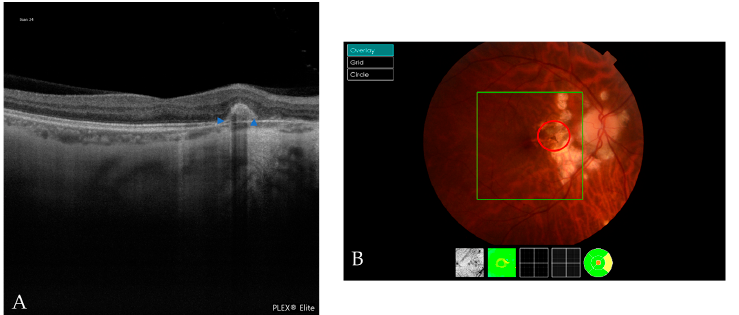
Figure 6. Multimodal image of a Fuch´s spot. ( A ) An OCT scan shows a Fuch´s spot (blue arrow- heads). ( B ) The red circle indicates the Fuch´s spot in the retinography. A BMD associated with patchy or macular atrophy was found in 42 (23.46%) eyes. A BMD associated with peripapillary atrophy was found in 83 (46.37%) eyes (Figure 7).